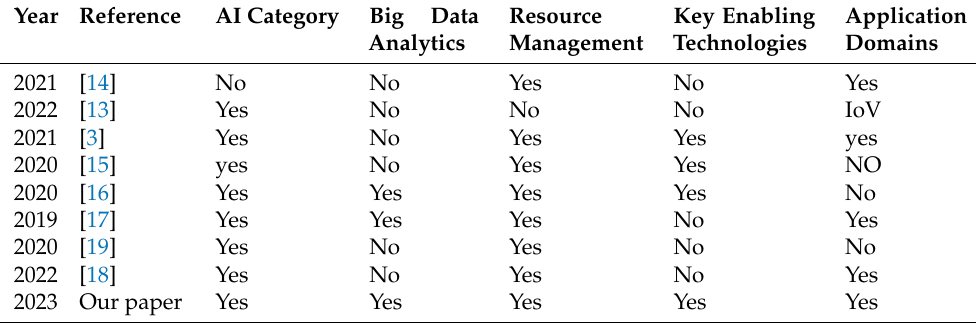
Table 1. Qualitative comparison of related